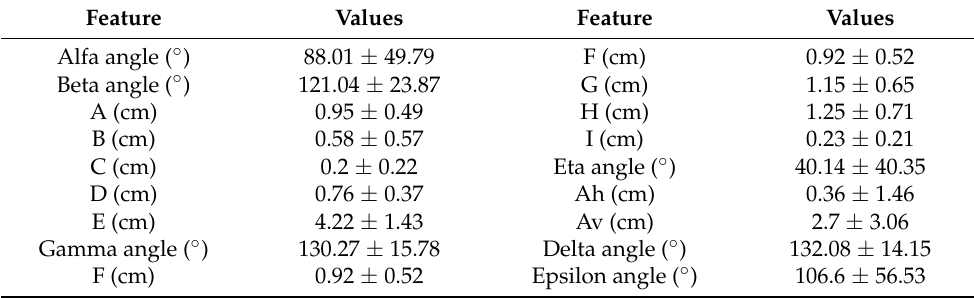
Table 3. Average results of measurements selected for the analysis.